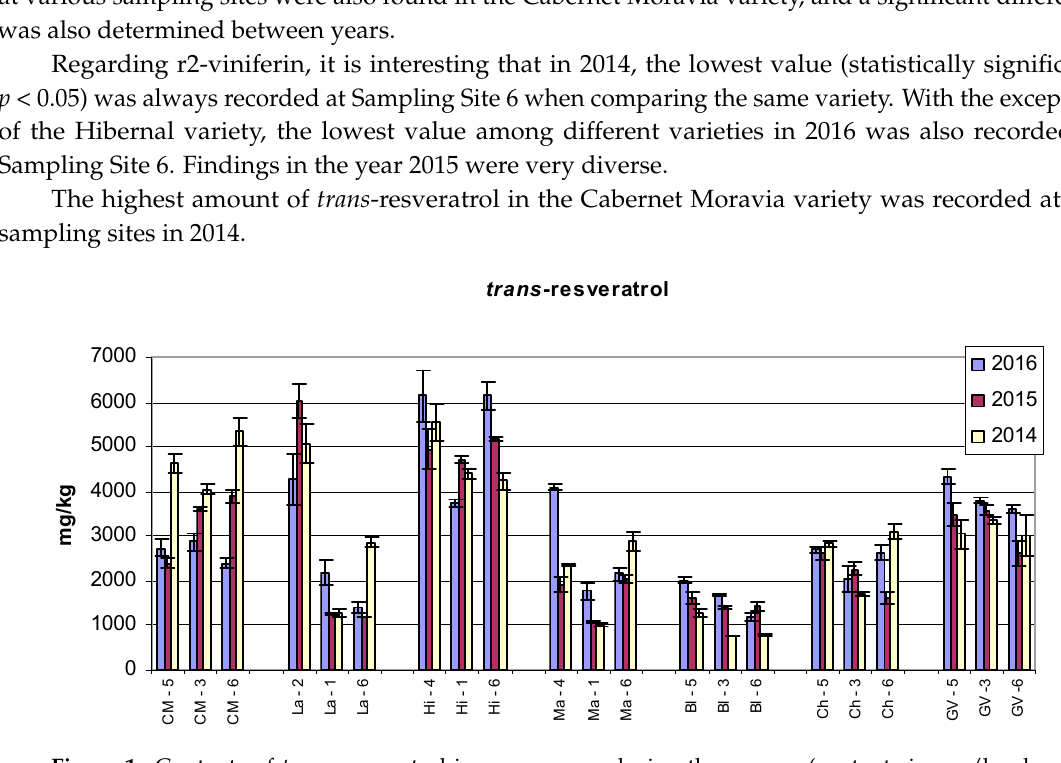
Figure 1. Contents of trans -resveratrol in grape canes during three years (contents in mg/kg dry weight). Example explanation of abbreviations: CM-5—“CM” is the variety, “5” is the sampling site (see Materials and Methods and Table 1). Bl: Blaufränkisch; Ch: Chardonnay; CM: Cabernet Moravia; GV: Green Veltliner; Hi: Hibernal; Ma: Malverina; La: Laurot.